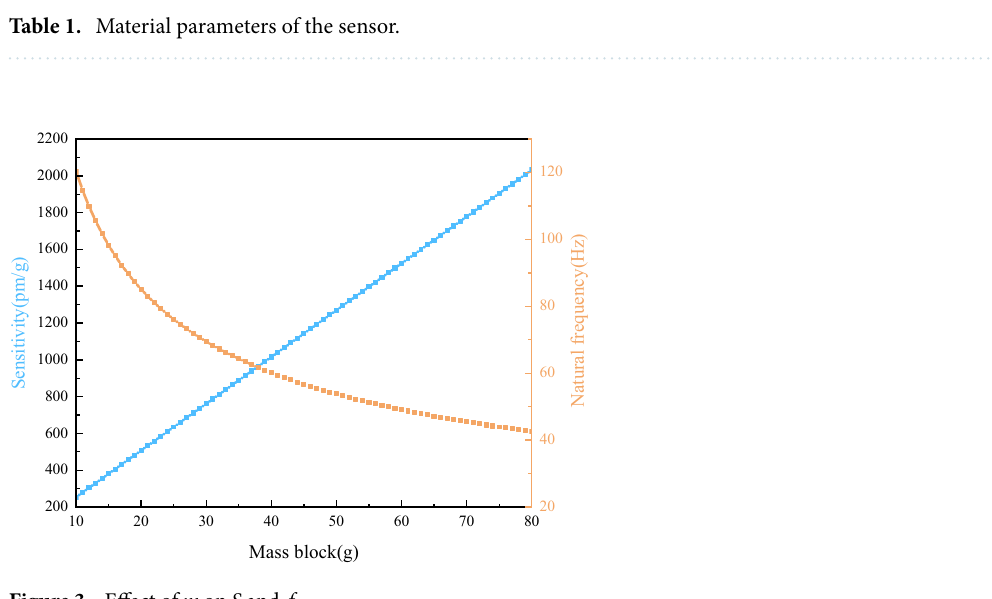
Figure 3. Effect of m on S and f